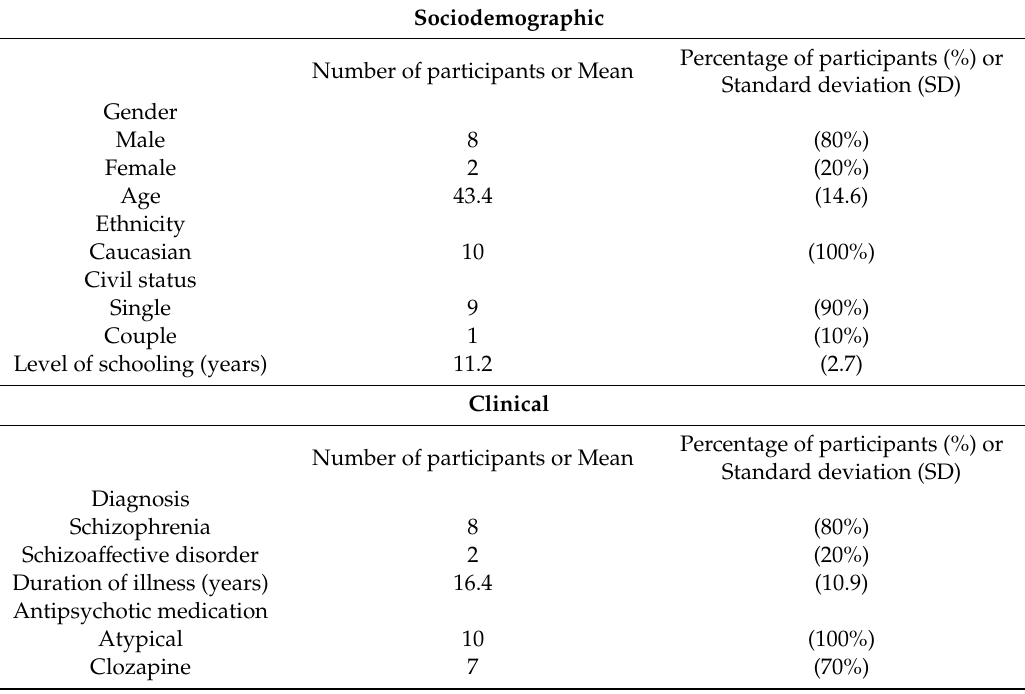
Table 1. Sociodemographic and clinical characteristics of the